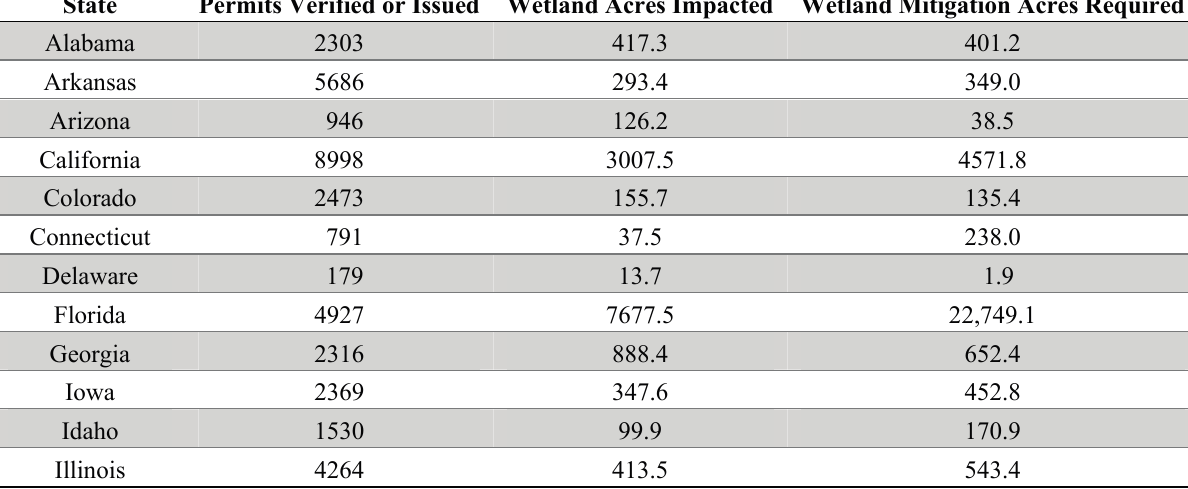
Table 1. Numbers of permits issued, area of wetland impacted, and required mitigation acres involved in 404 permits in the continental U.S. during 2010–2012 a